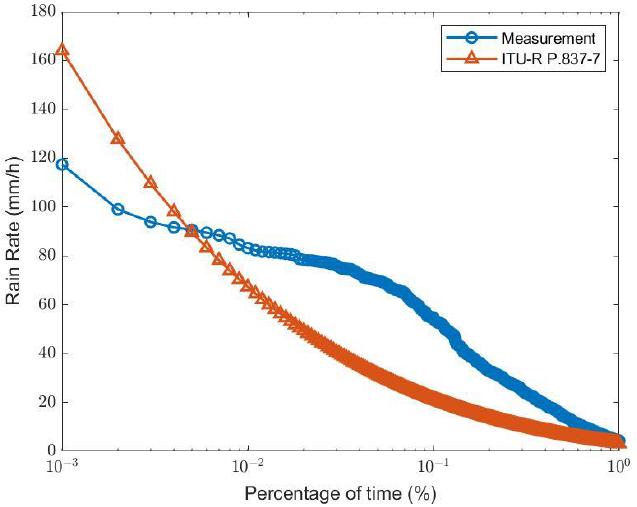
Figure 7. Cumulative distribution of the measured rain rates compared to the ITU-R P.837-7 model.